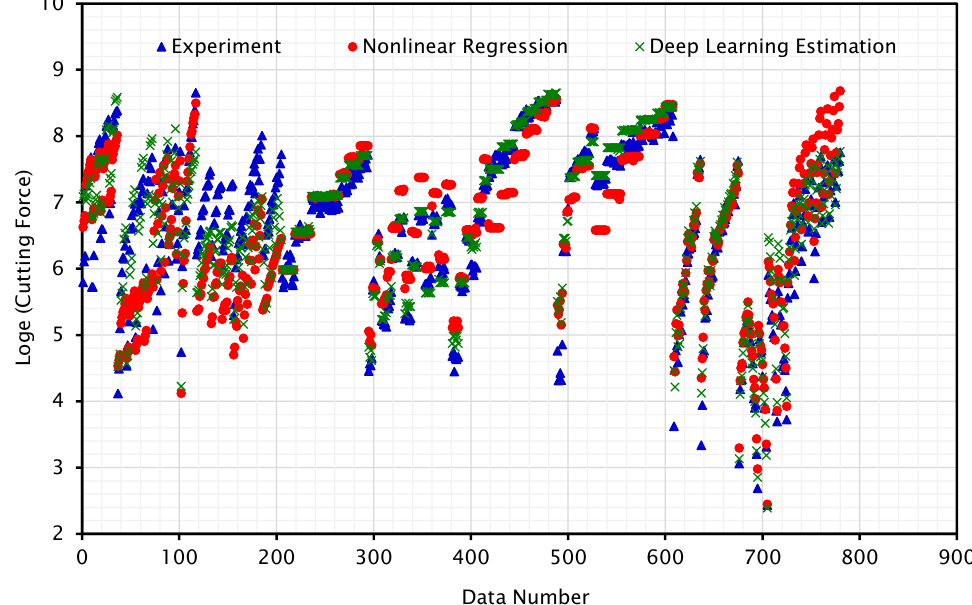
Figure 12. Scatter plot of experimental data and the calculated values by the regression methods for cutting force.